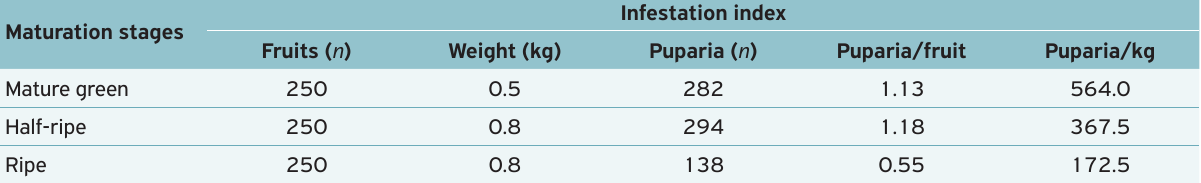
Table 2. Infestation index for frugivorous flies (Diptera: Tephritidae and Lonchaeidae) emerged from Surinam cherry, in three maturation stages. Maceió, Alagoas, from October 2010 to January